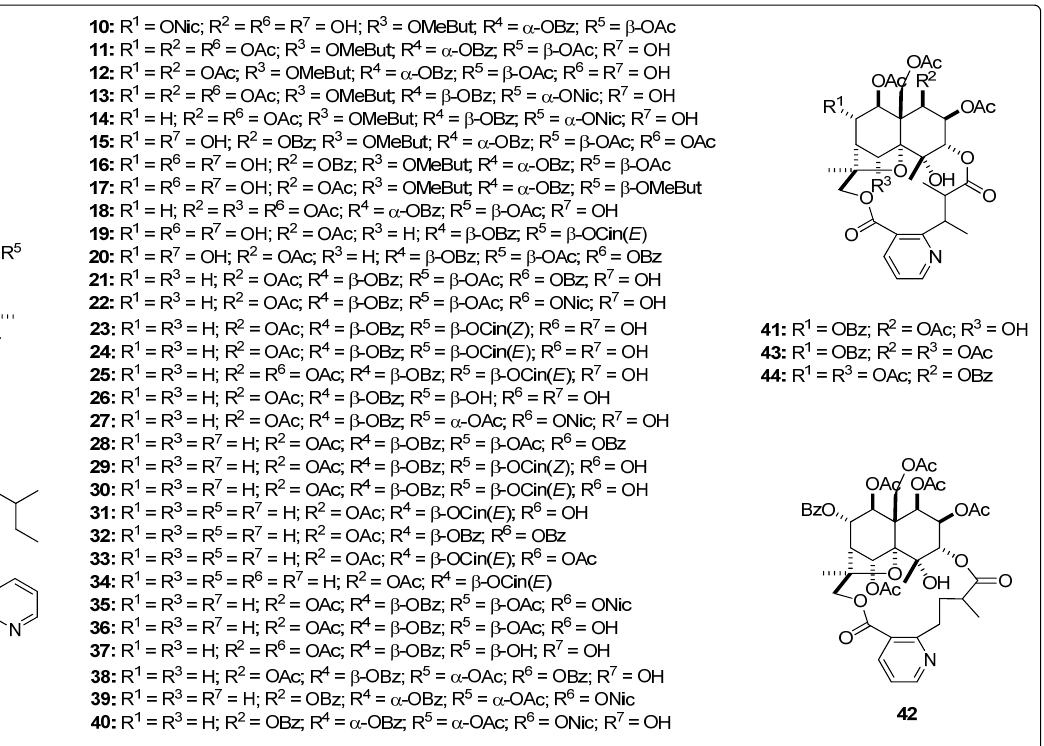
Figure 2. Structures of the tested agarofuran sesquiterpenes [19–23].